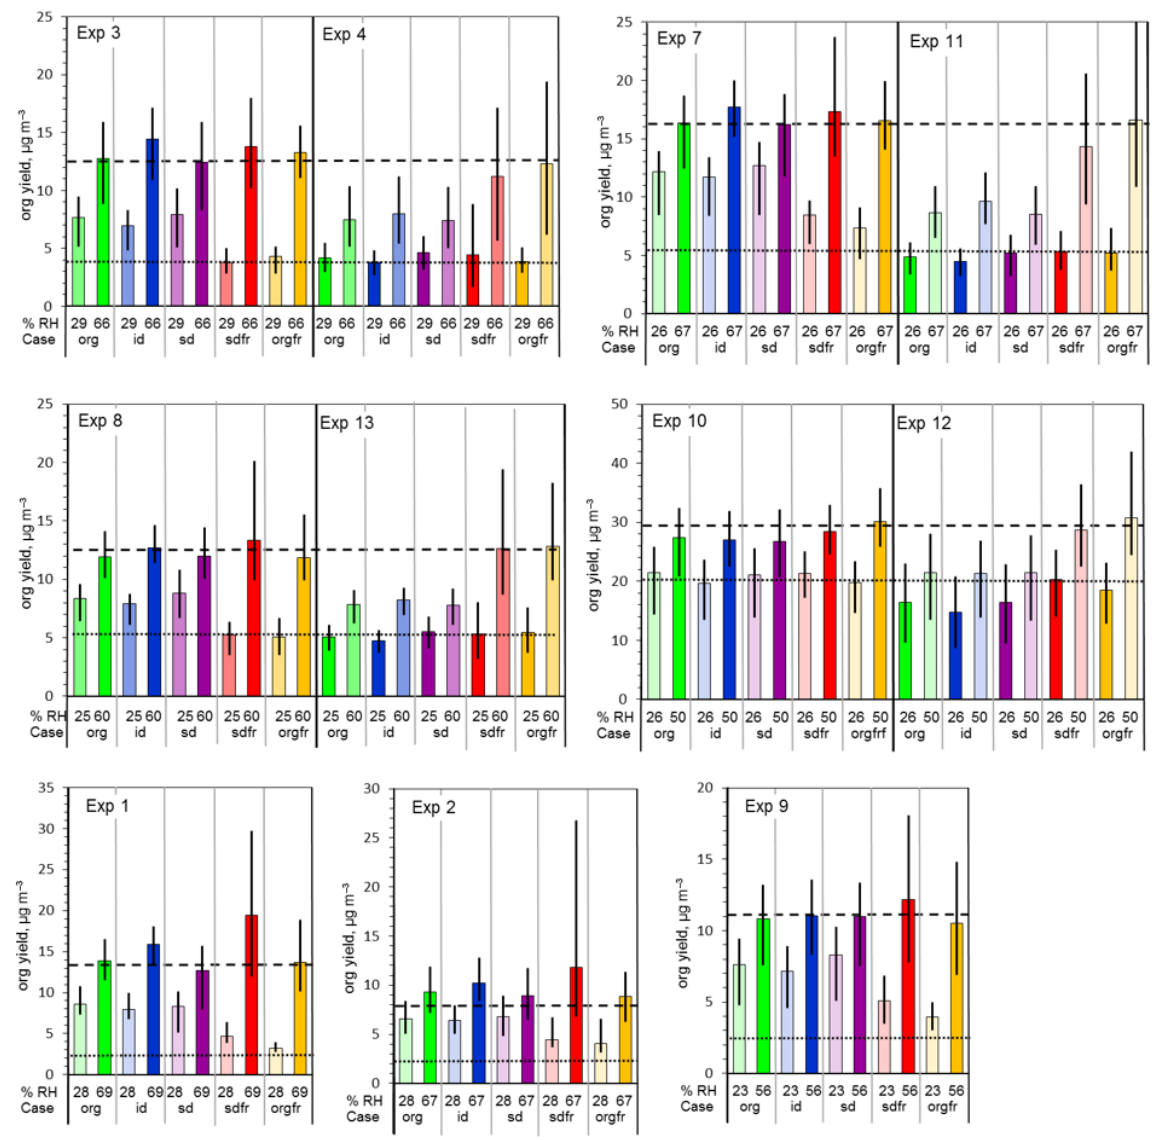
Figure 7. Calculated average organic yields for experiments at the measured RH (columns in full colours) and at the RH of the corresponding experiments (light colours; see Table 2 for reference) based on 10 randomly chosen volatility distributions for the cases org, id, sd, sdfr, and orgfr (identified by different colours). The vertical black lines in the columns indicate the range of values obtained for the calculations with the individual volatility distributions. The horizontal dotted line marks the measured value for the experiment performed at low RH, the dashed line the value for the experiment performed at high